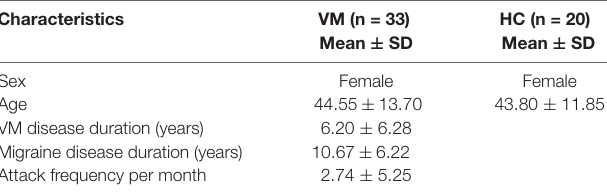
TABLE 1 | Demographic and clinical characteristics of patients.